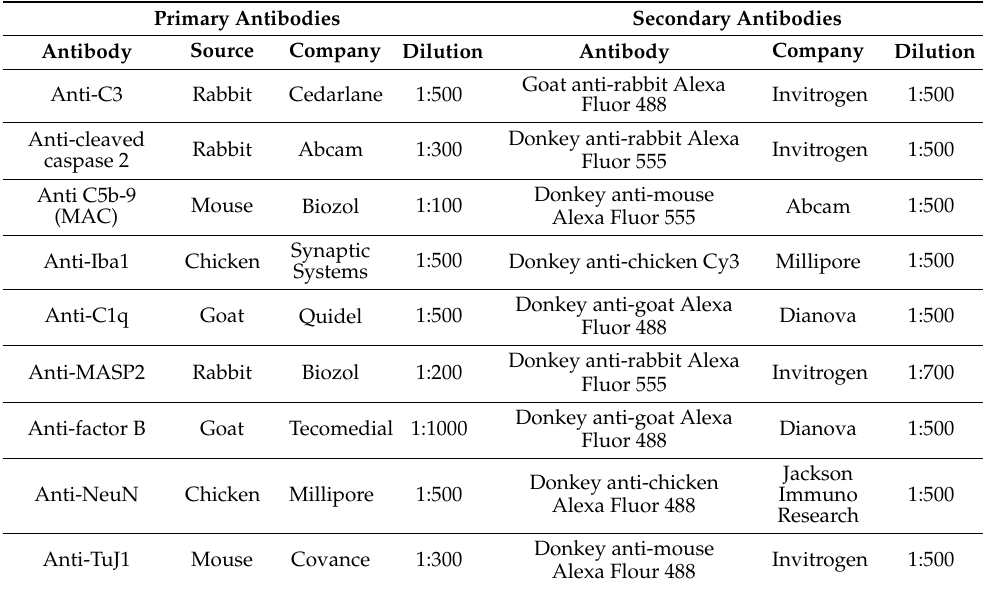
Table 1. Primary and secondary antibodies used for